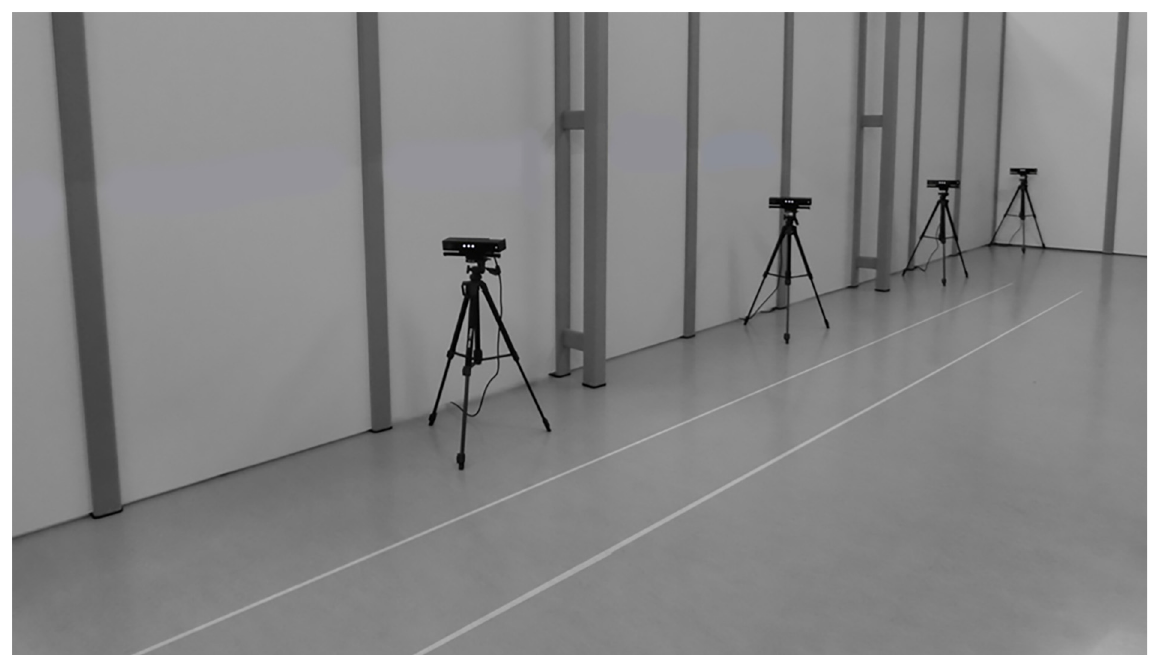
Fig 2. Overview of the multi-Kinect v2 set-up.